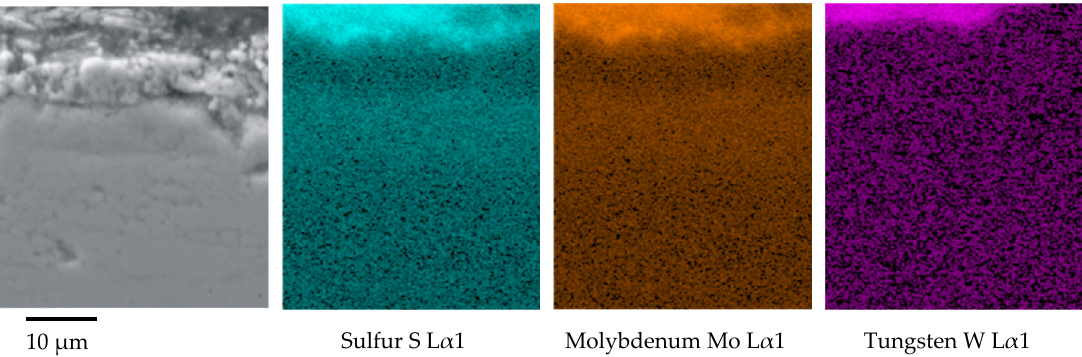
Figure 2. SEM Cross Sections and corresponding EDS maps of S, Mo and W distribution for layer option A.